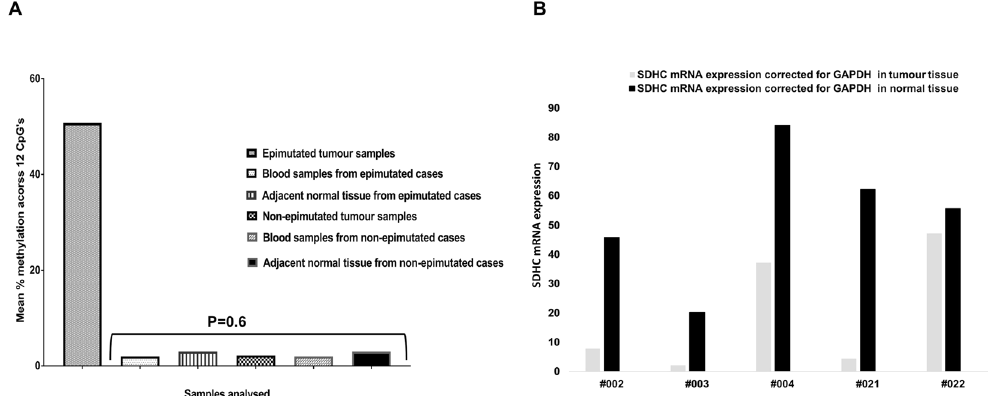
Figure 2. Figure ( A ) shows the difference in the mean % methylation of the SDHC promoter locus across 12 CpG’s in the tumour of the six hypermethylated cases and tumours of the non-epimutant cases and blood DNA and normal tissue of cases with and without an identified SDHC epimutation. Figure ( B ) shows reduced SDHC expression in the tumour versus normal tissue of 5/6 cases with an identified SDHC epimutation.